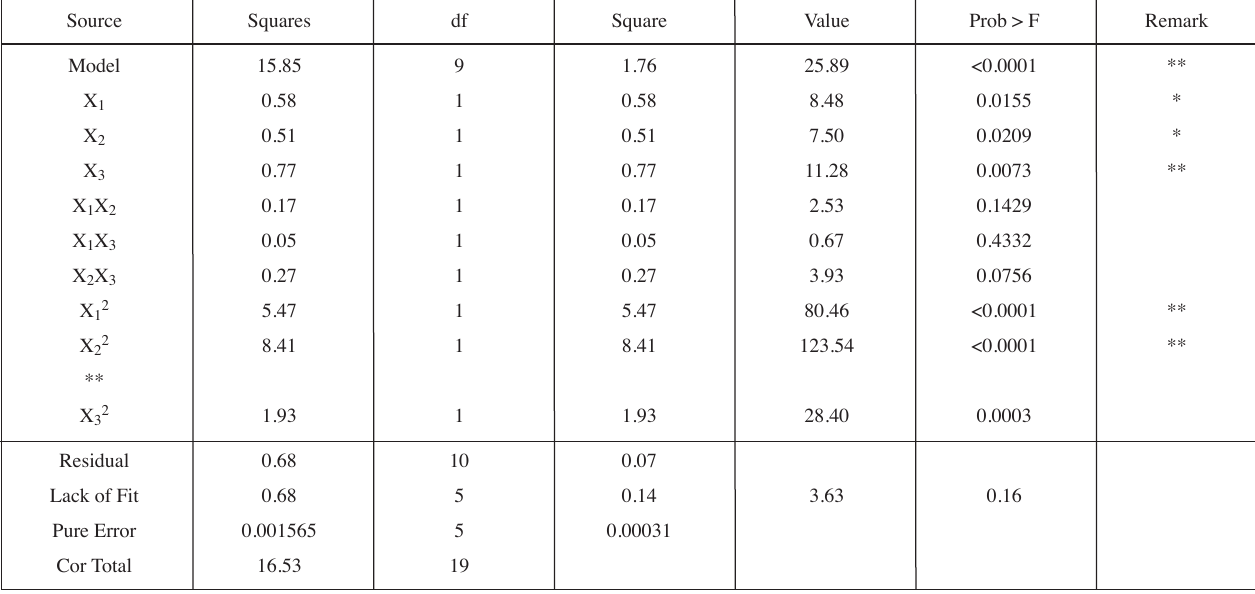
Tab. 3: Results of analysis of variance of the primarily established quadric regression